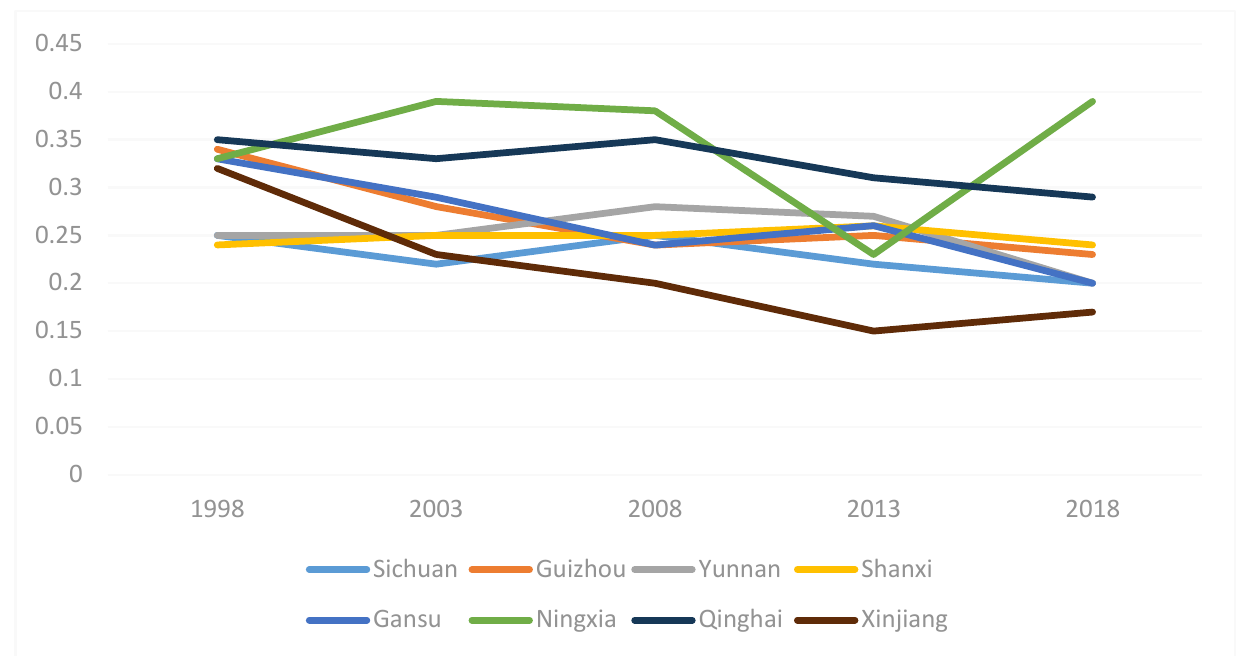
Figure 2. Productivity in Central Provinces 1998 – 2018.